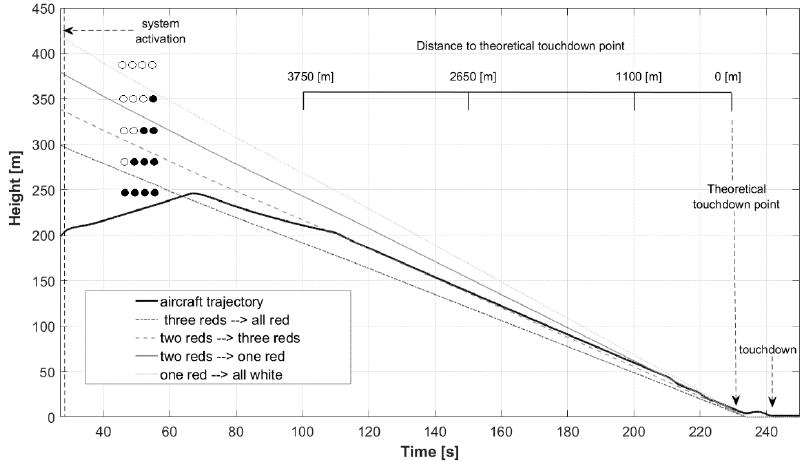
Figure 18. The vertical profile of the aircraft flight and sectors, related to specific PAPI light config- urations.